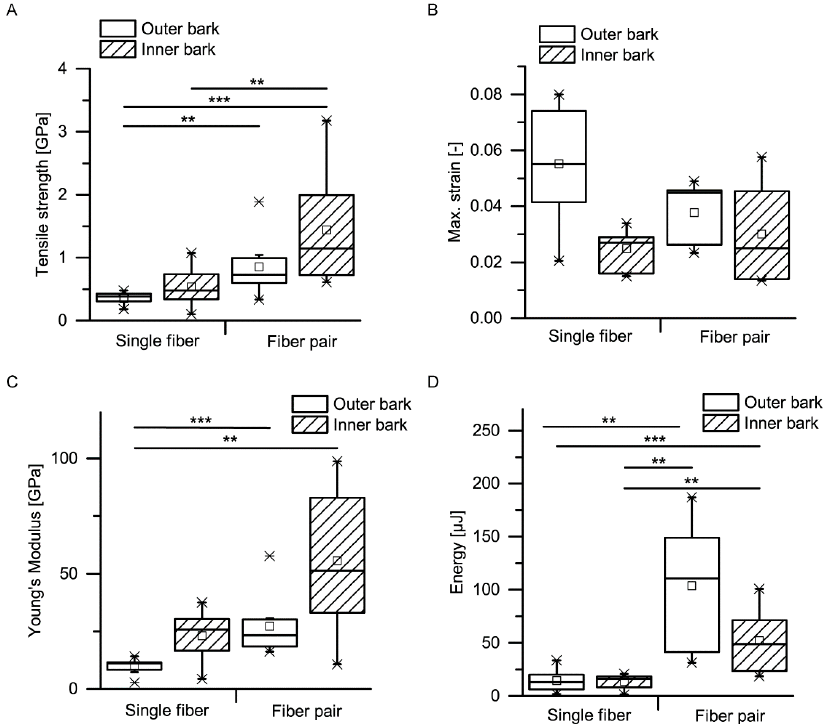
Figure 15. Tensile strength ( A ), maximum strain ( B ), Young’s modulus ( C ) and dissipated energy ( D ) of microtensile tests, comparing both single fibers vs. fiber pairs and samples extracted from the outer bark vs. samples extracted from the inner bark (statistical test: Kruskal–Wallis test; n = 10 for TS/sf/ib and YM/sf/ib; n = 9 for TS/ob/sf and YM/ob/sf; n = 8 for TS/fp/ob, TS/fp/ib, MS/sf/ob, YM/fp/ob, YM/fp/ib and E/sf/ob; n = 7 for MS/sf/ib and E/sf/ib; n = 6 for MS/fp/ib and E/fp/ib; n = 5 for MS/fp/ob and E/fp/ob). TS = tensile stress, MS = max. strain, YM = Young’s modulus, E = energy, sf = single fiber, fp = fiber pair, ob = outer bark, ib = inner bark. Significant differences are marked by asterisks, with the levels of significance indicated as follows: ** p < 0.01, *** p < 0.001.